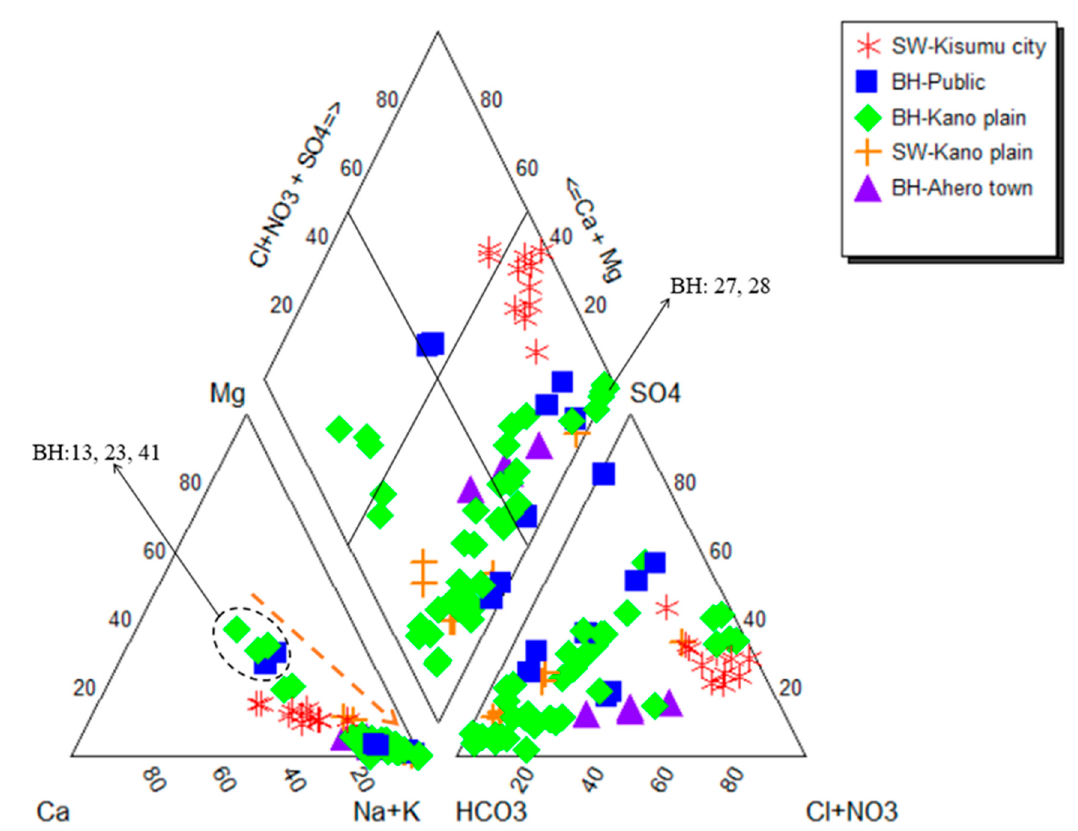
Figure 2. Piper diagram representation of major cations and anions (in % meqL − 1 ) for water characterization. Samples are categorized as, SW-Kisumu city: shallow wells located in Kisumu city; SW-Kano plain: shallow wells located in Kano plain; BH-Ahero town: boreholes located in Ahero town; BH-Public: boreholes in public institutions located in populated neighborhoods; and BH-Kano plain: boreholes located in the Kano plain. BH 13, 23, and 41 are located near Nandi / Kisian hills; BH 27 and 28 are located in Awasi town; dotted brown arrow shows increasing groundwater mineralization.